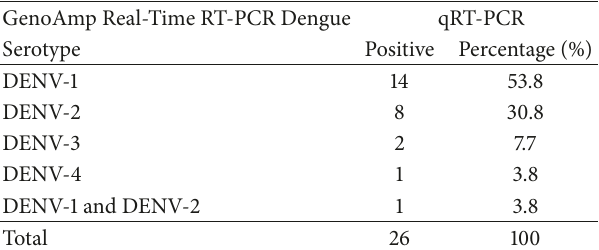
Table 3: Dengue serotypes identified by multiplex PCR in serum